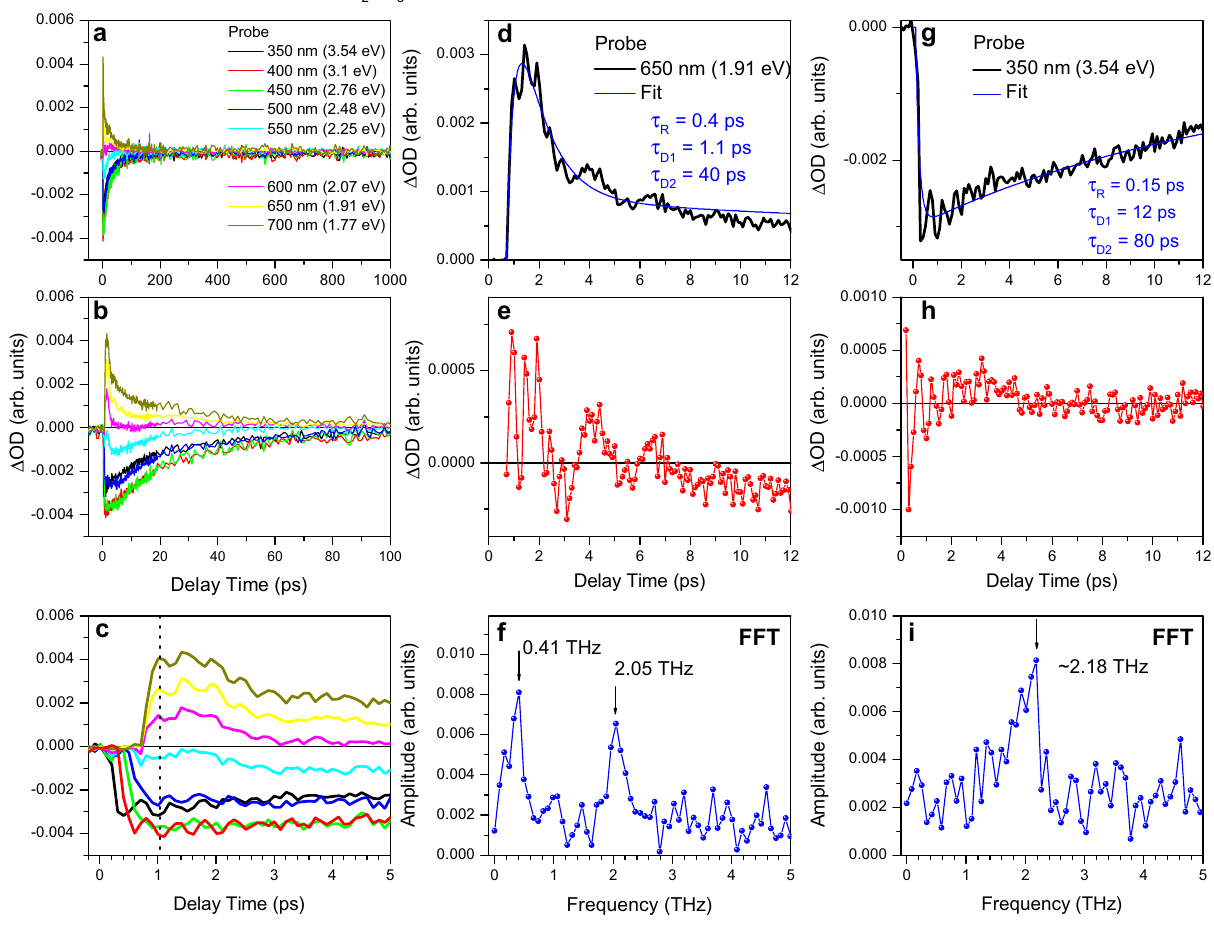
Figure 4. The pump–probe traces of the topologically trivial insulator phase of the 2D TI Bi 2 Se 3 . ( a – c ) The pump–probe traces for the 2 QL thick Bi 2 Se 3 film, which were measured with the 340 nm (3.65 eV) pumping of 0.5 mW power at the specific probe wavelengths, as indicated by the corresponding colors, and plotted using different timescales. The vertical dotted line in ( c ) indicates the antiphase character of LO-phonon oscillations for traces measured with E probe = 3.54 and 1.77 eV. ( d ) and ( g ) Some of the traces shown in parts ( a – c ) and the corresponding fits, as indicated. The corresponding rise-time and decay-time constants are listed for both panels. ( e ), ( h ) and ( f ), ( i ) The extracted oscillatory parts of the pump–probe traces shown in parts ( d ) and ( g ) and the corresponding fast Fourier transformation (FFT), respectively. The center frequencies are indicated in parts ( f ) and ( i